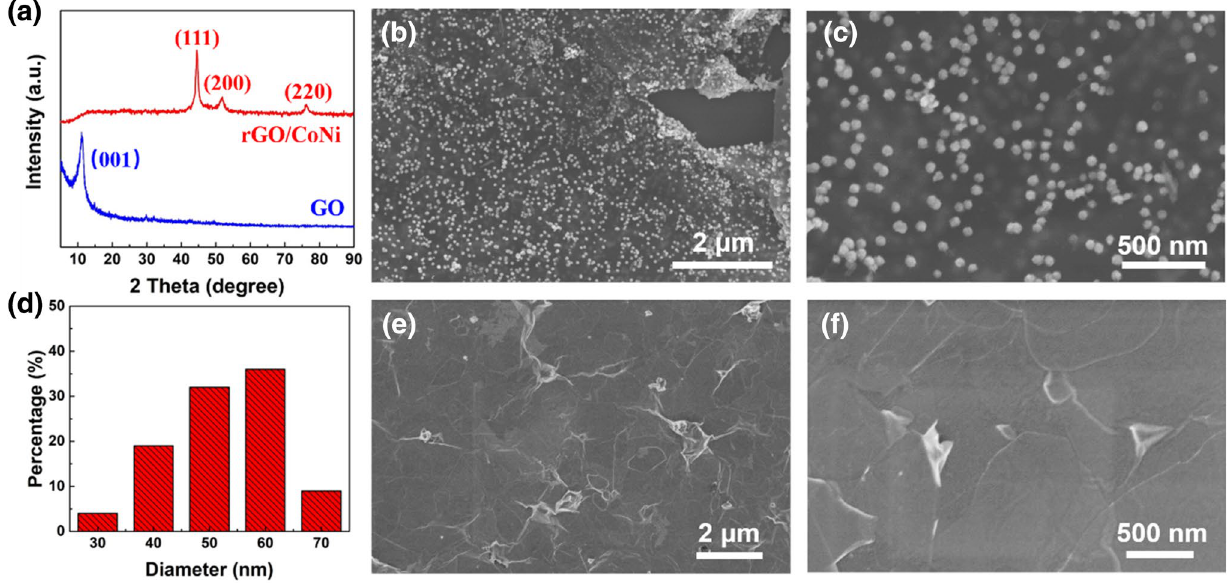
Fig. 2 a XRD patterns of GO and rGO/CoNi; b , c SEM images of rGO/CoNi; d size distribution of CoNi in rGO; e , f SEM images of